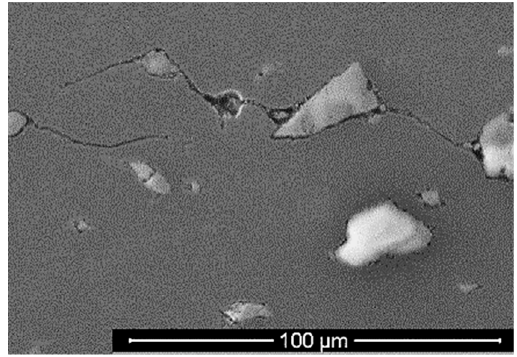
Figure 13. Crack propagation in the homogenous specimen matrix (magnification: 1500 × ).